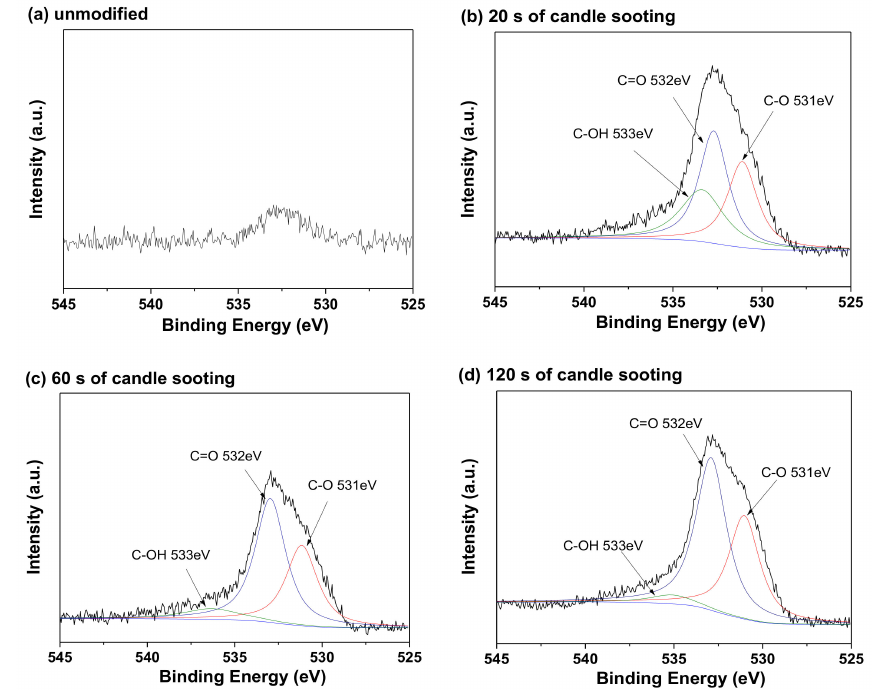
Figure 7. O1s XPS of the surfaces of the ( a ) unmodified carbon cloth and those modified by candle sooting for ( b ) 20 s, ( c ) 60 s, and ( d ) 120